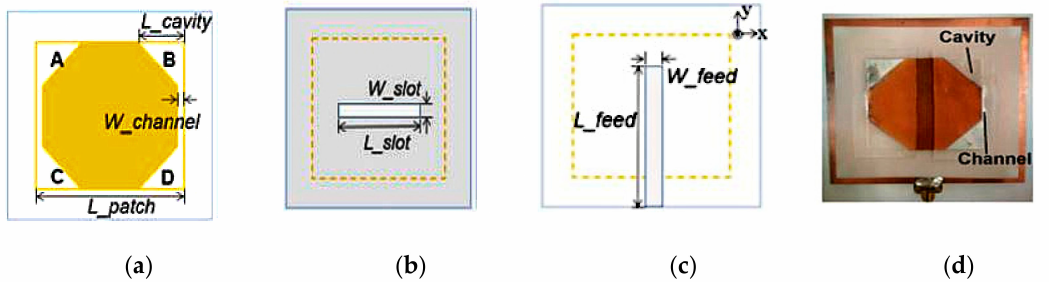
Figure 20. Schematic of antenna proposed in [53]: ( a ) upper layer, ( b ) top view, ( c ) bottom view of the lower layer, ( d ) top view of fabricated